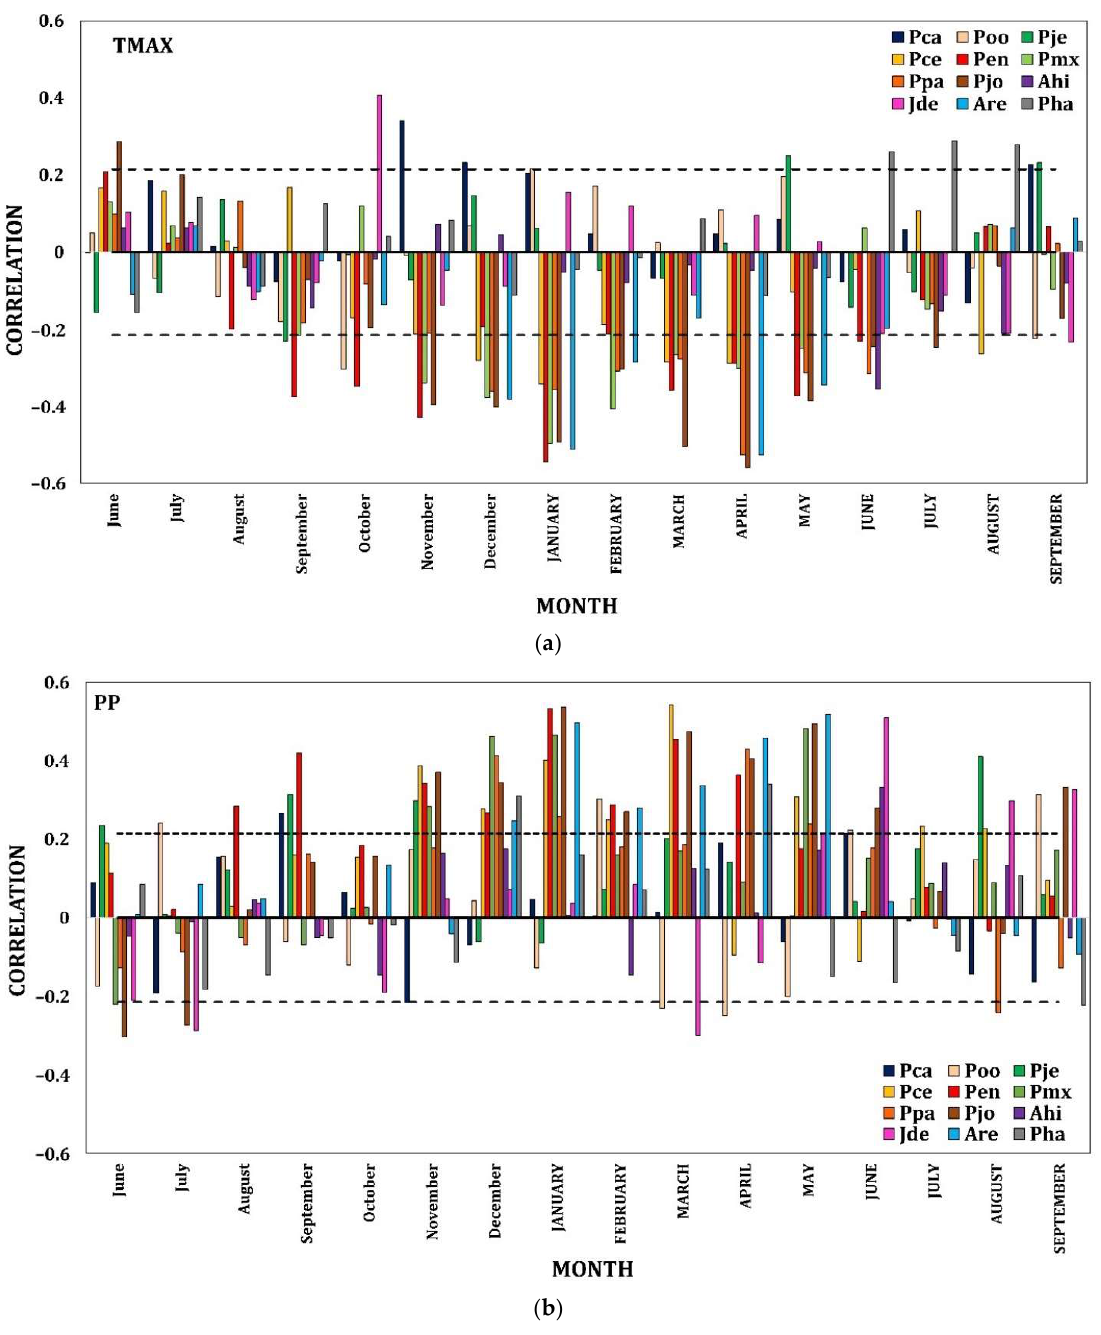
Figure 3. Radial growth–climate associations. Coefficients of correlation (Pearson) between TMax ( a ) and PP ( b ) and the ring width index (RWI) of twelve conifer species as a function of elevation. Significant positive and negative correlations among monthly values from the previous Jun to SEPTEMBER of the year of growth and the chronologies of ring width are shown. Dashed horizontal line shows the 0.05 significance level.